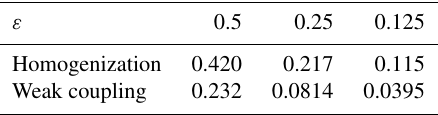
Table 2. The relative error on the standard deviation of the exit times | σ | /σ [− 1 , 1 ] of − σ 1 (τ) 0 (τ) 0 (τ) where σ 0 (τ) is the standard deviation of exit times from [− 1 , 1 ] of the full triad system (Eq. 15) and σ 1 (τ) is the standard deviation of exit times of the parameterized systems √ 2 /δ , γ 2 = 1 of Eqs. (18) and (16). Parameters are chosen as in Table 1. These values are calculated from 1000 independent